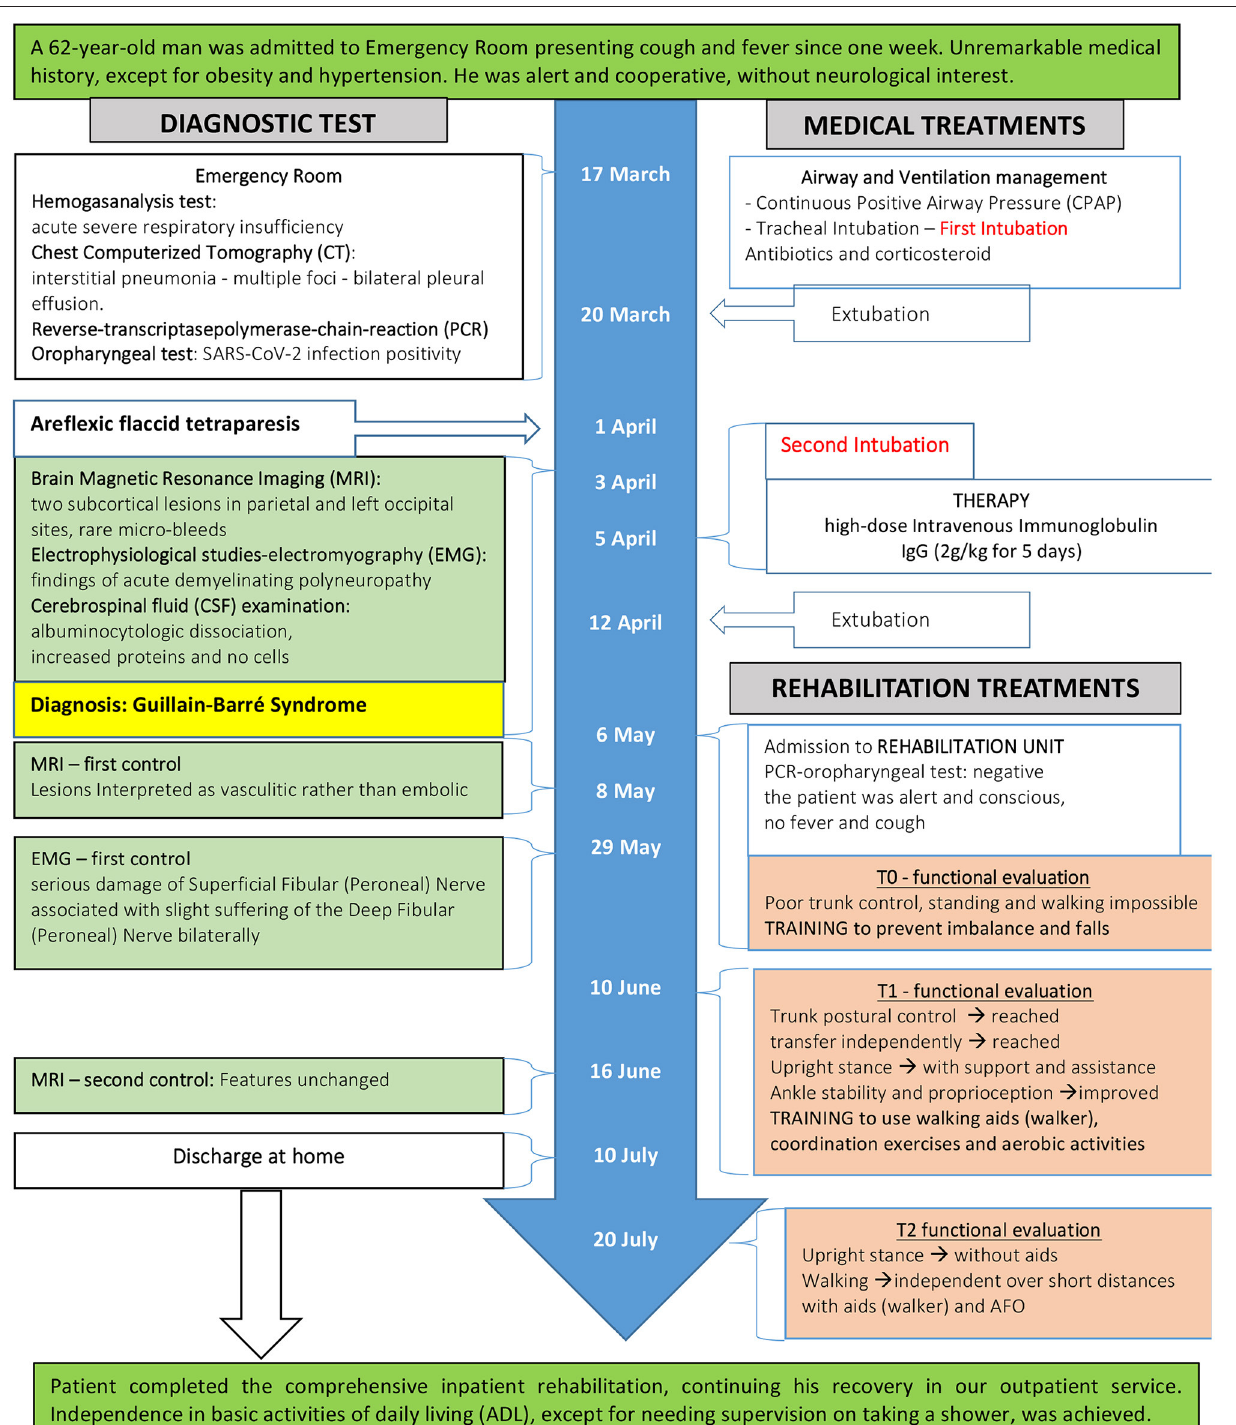
Frontiers in Neurology |